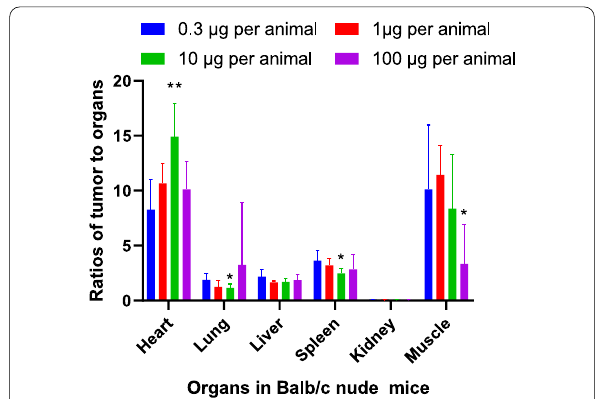
Fig. 1 Tumor-to-organ ratios for different masses of 68 Ga-NOTA-Nb109 in Balb/c A375-hPD-L1 tumor-bearing nude mice ( n 6) at 90 min after the tracers injection. Data represent the = mean SD (** P < 0.01, * P < 0.05). P values were calculated vs. the ± 0.3-μg group by a two-sided test